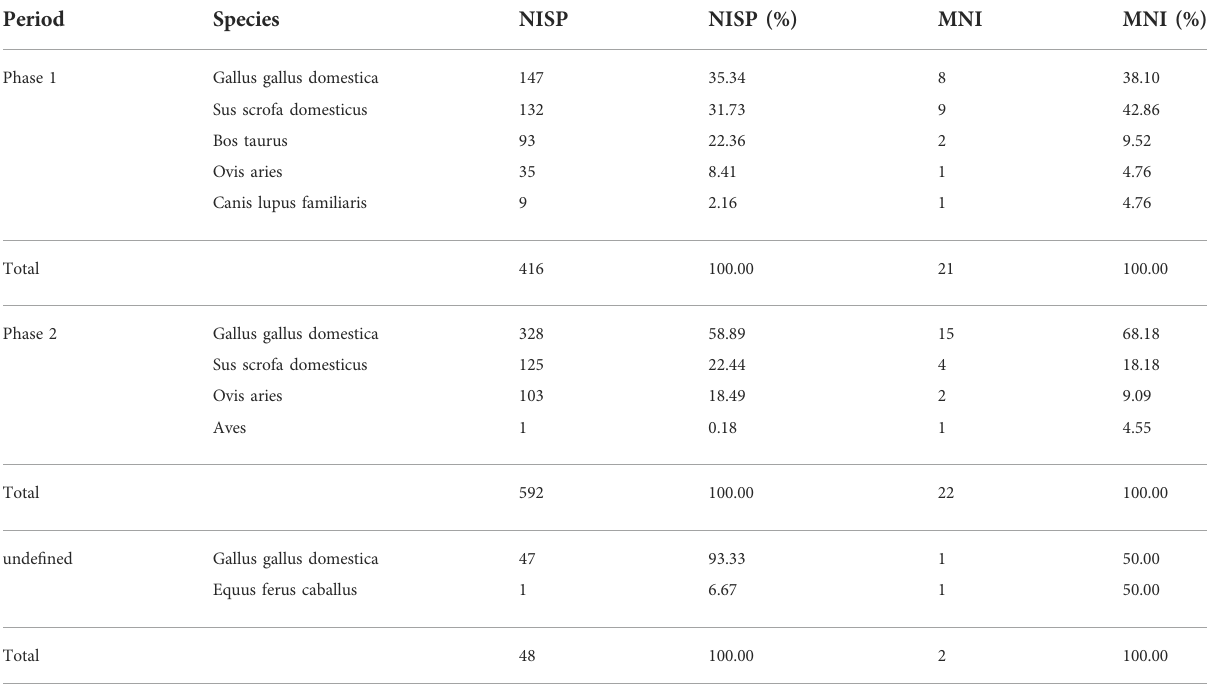
TABLE 1 Proportion of identi fi ed animal remains from the excavation of the HSG Cemetery in 2018. Period